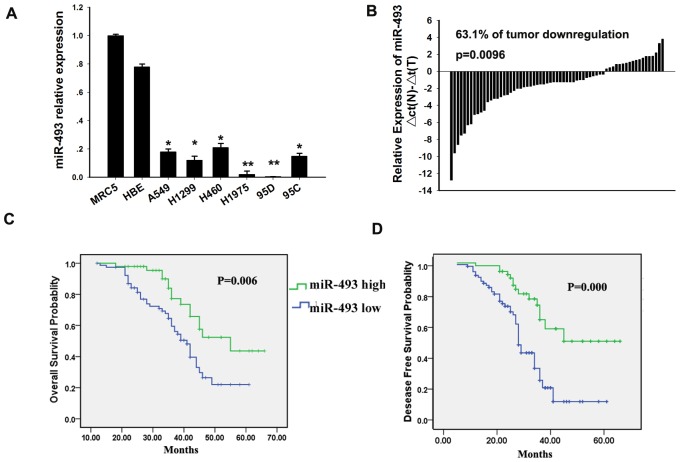
miR-493 expression levels are frequently downregulated in human lung cancer and associated with Prognosis.(A) The relative expression levels of miR-493 in 6 cell lines derived from lung cancer and one lung fibroblast line (MRC5), as well as an immortalized human bronchial epithelial cell (HBE) were determined by qRT-PCR. The data are presented as means ± SEM from at least 3 separate experiments.* p<0.05, **p<0.01. (B) The miR-493 expression levels in 65 paired human NSLCC and corresponding normal tissues were examined by real-time PCR, using GAPDH as an internal control. The expression value (ΔCt(N)- ΔCt(T)) represents the difference of in the miR-493 levels between normal tissue and tumor. A expression value >1 indicates that the miR-493 levels is increased in tumors. A expression value <1 indicates that the miR-493 levels is decreased in tumors. A paired t test (univariate) was used to compare the difference of between the normal group and cancer group. (C) Low levels of miR-493 correlates with shorter survival. The OS and DFS curves for all studied patients with high or lowmiR-493 expression.